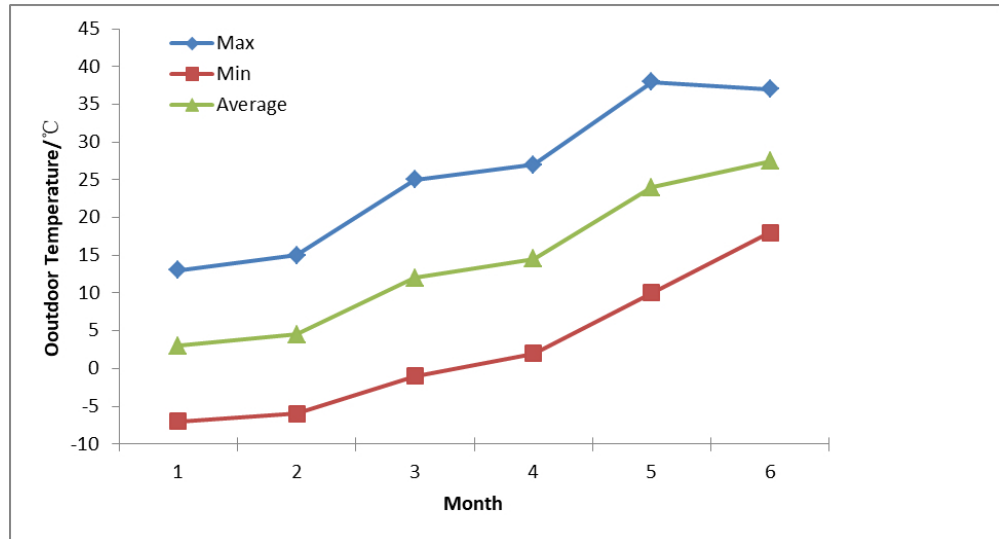
Figure 10. Outdoor temperature change of Jinan from January to June 2019.